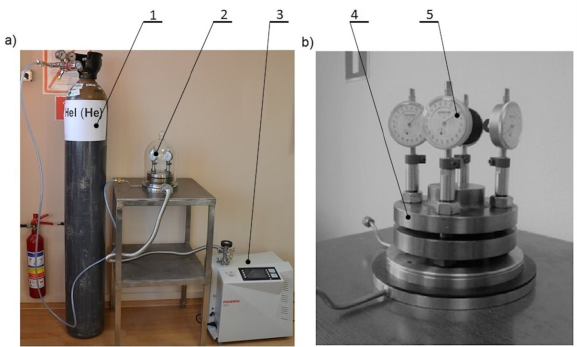
Figure 4: Test rig used for leakage measurement from the flange- bolted joint; 1- helium reservoir, 2- glass cover, 3 – helium detector, 4 – flange bolted joint with inspected gasket, 5 – micrometer sen- sor